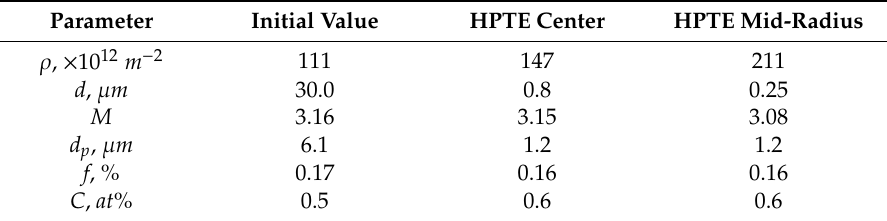
Table 3. Measured parameters used for the strengthening